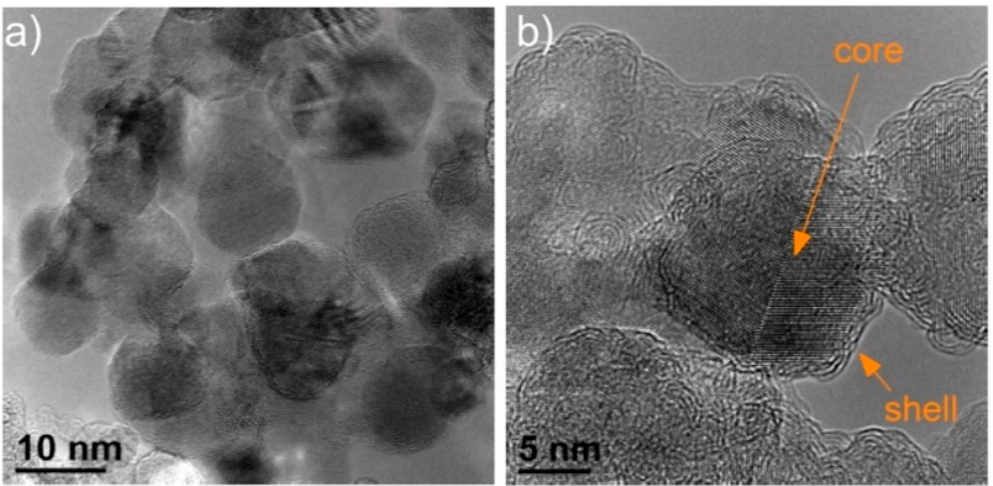
Figure 41. ( a ) TEM and (b) HRTEM micrographs of nanodiamonds. Reproduced with